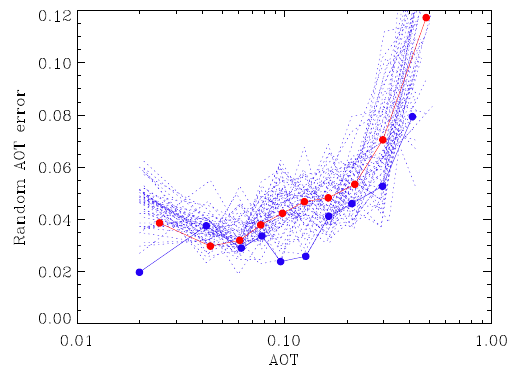
Fig. 7. Terra random AOT errors estimated from the Maritime Aerosol Network (solid blue) or AERONET (solid red). The blue dotted lines are MODIS random error estimates from AERONET data sampled to mimic Maritime Aerosol Network observing